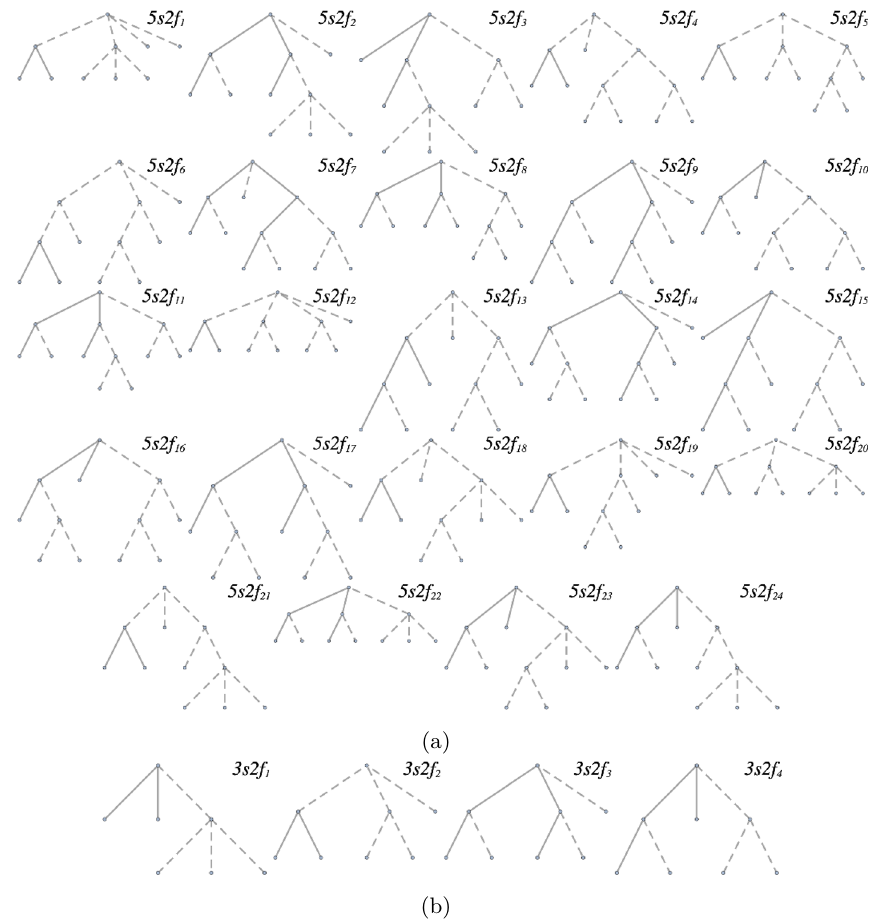
Figure 10. (a) The 5 s 2 f topologies relevant only to the single-derivative operator O D 20 . Only those topologies allowing one arrow-preserving internal fermion line give completions allowed in our framework. Topologies 5 s 2 f 4 , 5 s 2 f 7 and 5 s 2 f 10 contain heavy fields that couple only to other exotics in the diagram. (b) The UV diagrams associated with the 3 s 2 f operator O D 21 . Only the last two diagrams can generate the operator under our model-building